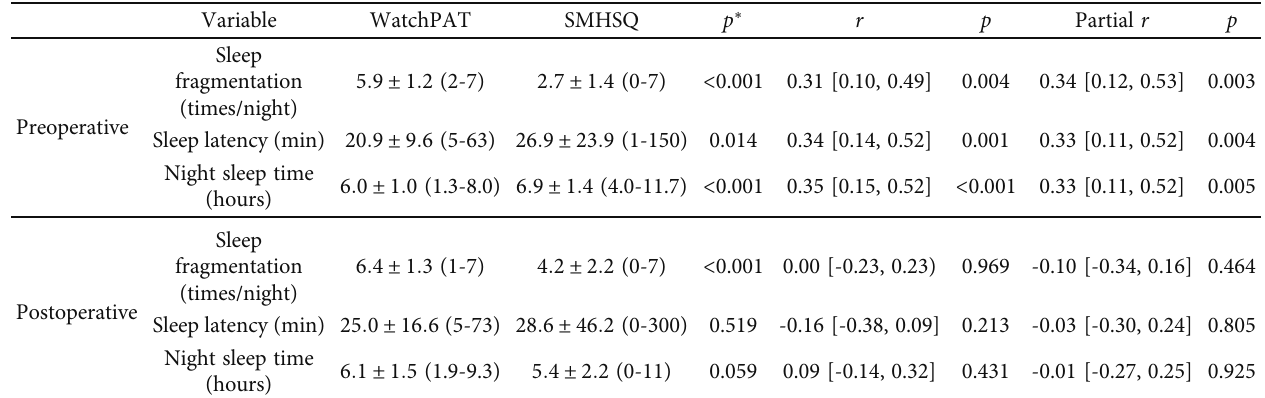
Table 2: Correlations of sleep fragmentation, sleep latency, and sleep time between WatchPAT and SMHSQ.